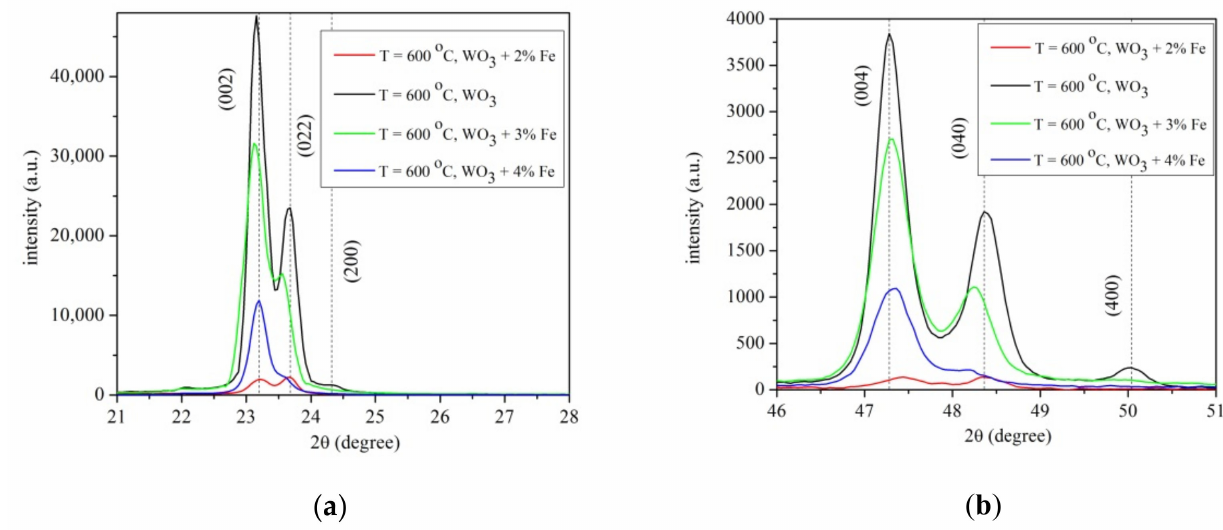
Figure 3. ( a , b ) X-ray pattern of pure and 2, 3 and 4% Fe doped WO 3 layers grown on sapphire substrate at 4 h deposition time and substrate temperature T = 600 ◦ C. ( a ) pure and 2, 3 and 4% Fe doped WO 3 in the range 2 θ = 21–28 ◦ ; ( b ) pure and 2, 3 and 4% Fe doped WO 3 in the range 2 θ = 46–51 ◦